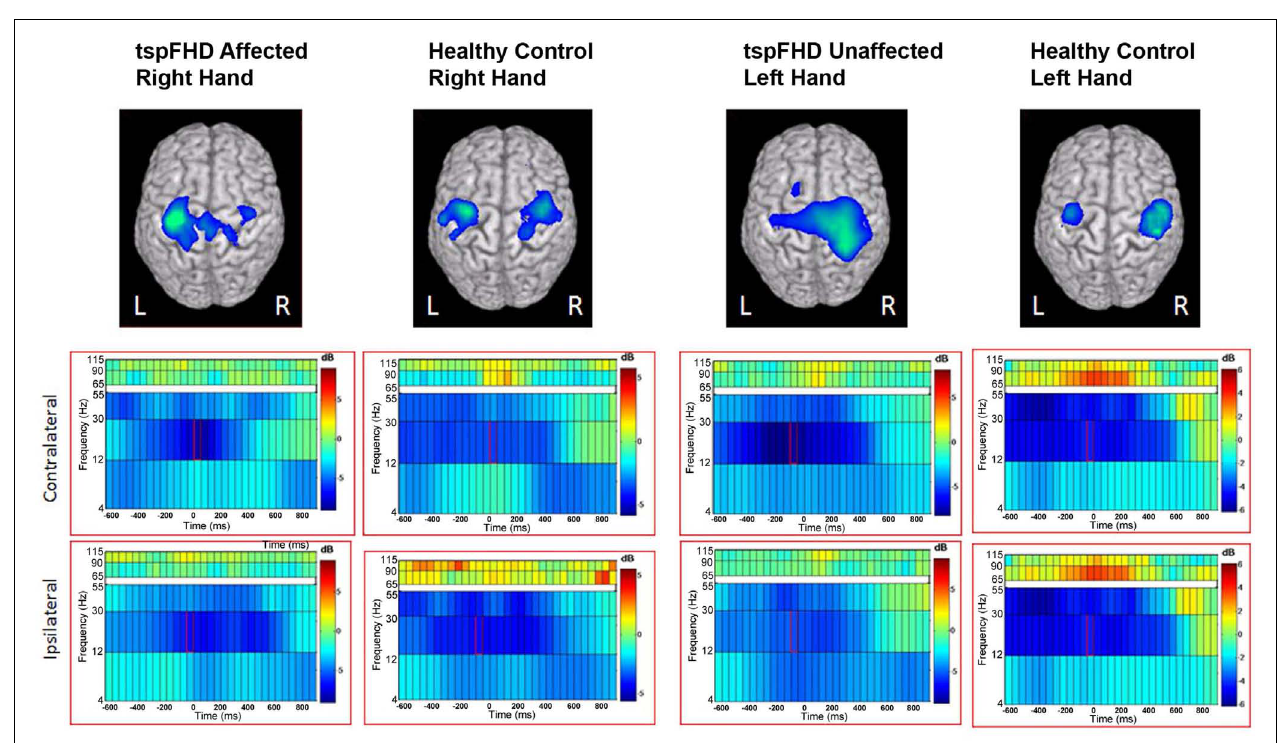
displays 600ms prior to the self-paced button press (time = 0ms) through 1000ms after the button press. Frequency bands are represented along the y axis.The peak activation in the contralateral and ipsilateral primary motor cortex is shown with the corresponding spectrograms below.